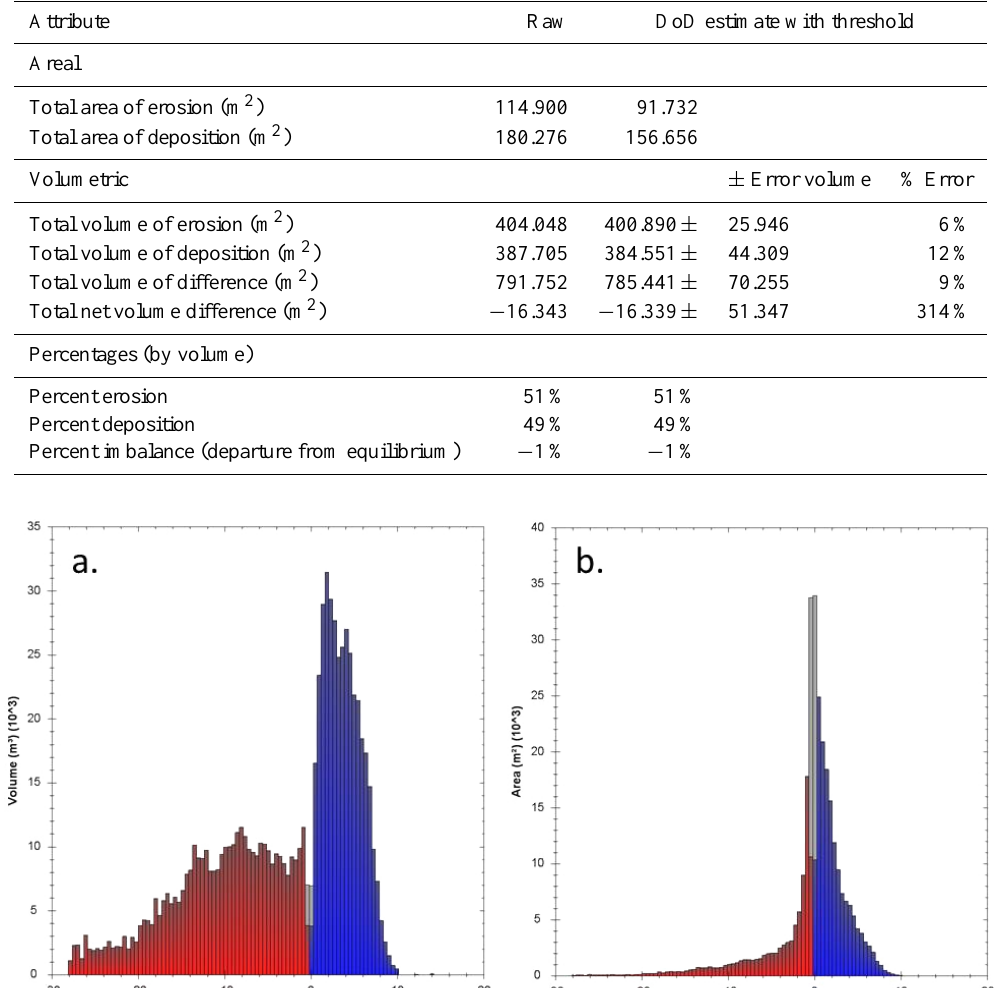
Figure 3. DoD map over shaded relief of the Rotolon